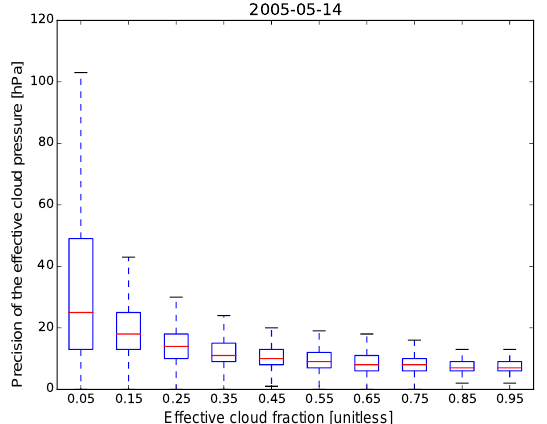
Figure 5. Box-and-whisker plot of the precision of the effective cloud pressure as a function of the effective cloud fraction for 14 May 2005.